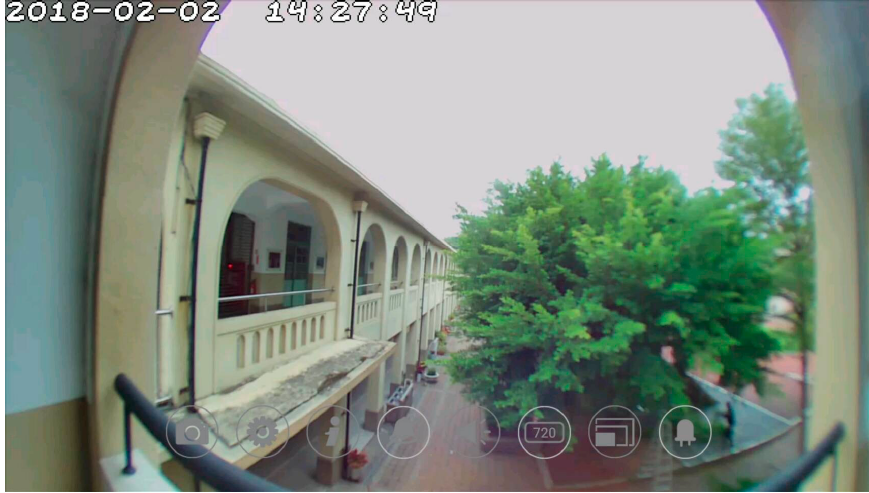
Figure 7. Panorama of a site displayed on a mobile device.